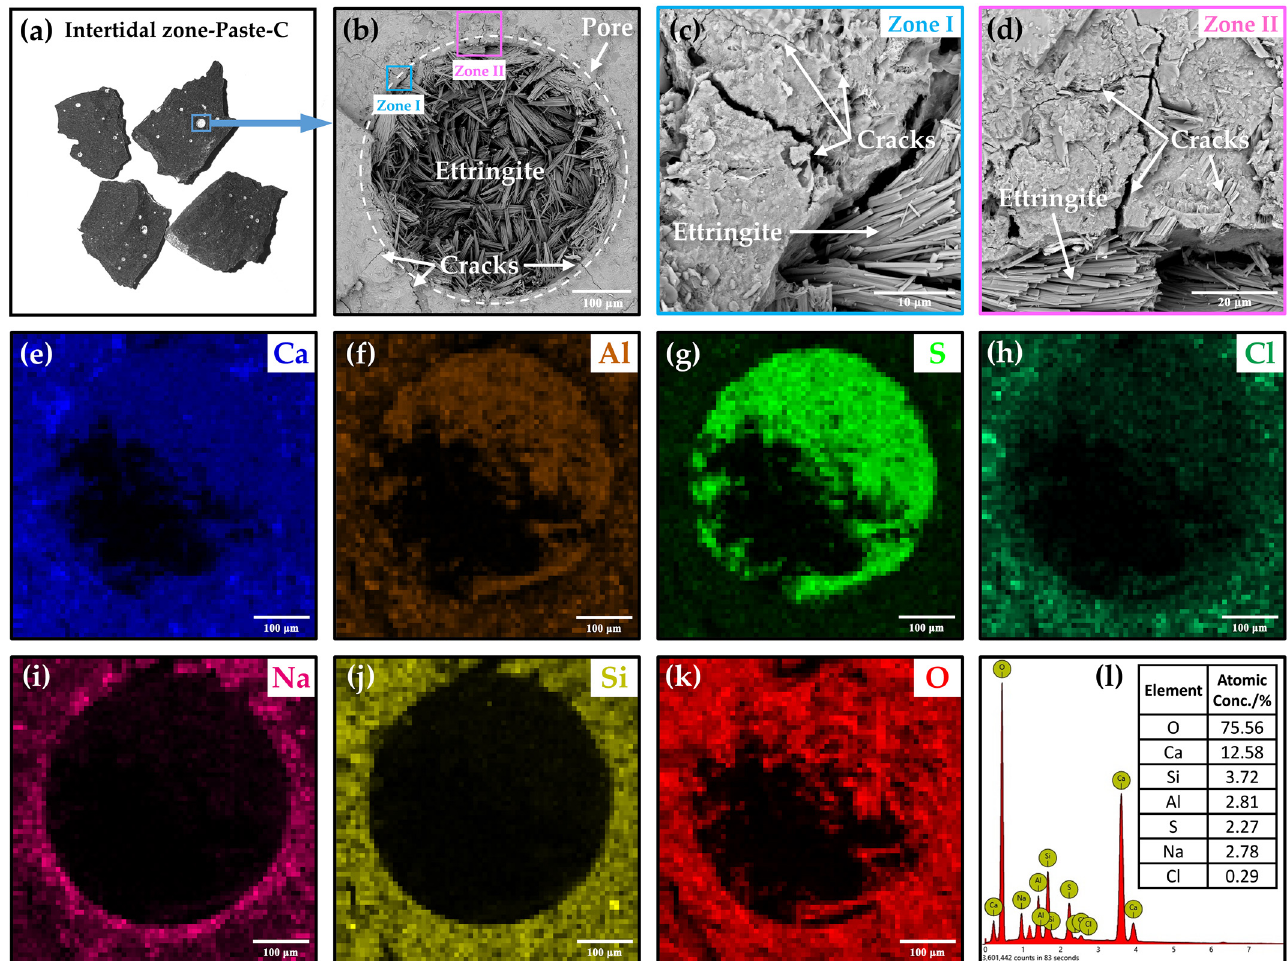
Figure 10. The internal microstructure deterioration characteristics of Paste-C after 180 days of dry–wet cycles-coupled chloride ion erosion. ( a ) The internal section photo of Intertidal zone-Paste-C. The SEM photos of internal microstructure at ( b ) 520 magnification, ( c ) 7200 magnification and ( d ) 3800 magnification. ( e – k ) The EDS-Mapping of ( b ). ( l ) The elements content of ( b ). Ettringite (C 3 A·3CaSO 4 ·32H 2 O) is an important hydration product that exists in the